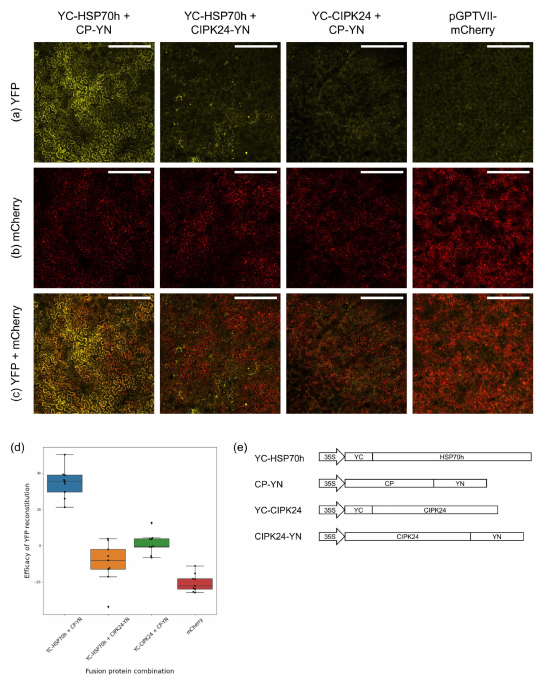
Figure 2. Summary of the BiFC assay conducted to investigate the interaction of GLRaV-3 heat shock protein 70 homolog (HSP70h) and GLRaV-3 major coat protein (CP) in planta . Fluorescent microscopy images are of the underside of Nicotiana benthamiana leaves infiltrated with various combinations of bimolecular fluorescence complementation (BiFC) constructs indicated above each image. All combinations of BiFC constructs were co-infiltrated with silencing suppressor p19, and pGPTVII-mCherry, expressing red fluorescent protein mCherry. The red colour represents mCherry emissions, while the yellow represents the signal emitted by reconstituted YFP. Scale bars indicate a distance of 500 microns. ( a ) YFP emission for each combination; ( b ) mCherry emission for each combination; ( c ) A composite image of both YFP and mCherry emission; ( d ) A box-and-whiskers plot summarising the efficacy of YFP reconstitution of each protein combination, as quantified by subtracting the mean intensity of mCherry from the mean intensity of YFP. Individual plot points are shown as black dots; ( e ) Schematic presentation of the expression cassettes for YC or YN fusion proteins. YC-HSP70h: C-terminal fragment of yellow fluorescent protein (YFP) fused to N-terminus of HSP70h; CP-YN: N-terminal fragment of YFP fused to C-terminus of CP; YC-CIPK24: C-terminal fragment of yellow fluorescent protein (YFP) fused to N-terminus of Arabidopsis thaliana protein kinase CIPK24 (CIPK24); CIPK24-YN: N-terminal fragment of YFP fused to C-terminus of